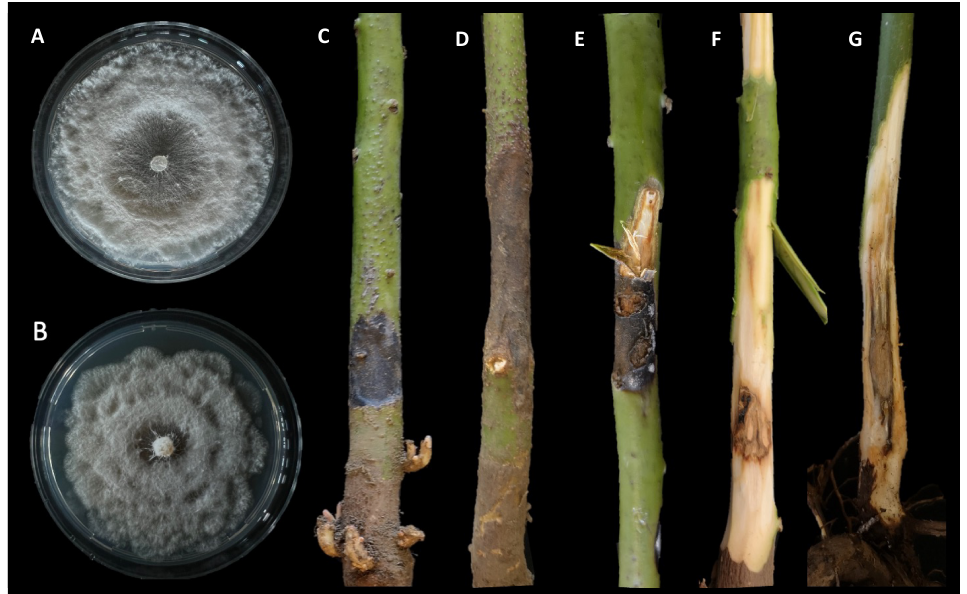
Figure 1. Symptoms caused by Neopestalotiopsis spp. on avocado. ( A ) Colony of N. rosae isolate AC50 grown on PDA for 7 days; ( B ) colony of N. siciliana isolate AC46 grown on PDA for 7 days; ( C ) external lesion; ( D ) shrinkage of the necrotic tissue; ( E ) external lesion with bark cracking; ( F , G ) wood discoloration and brownish streaking.